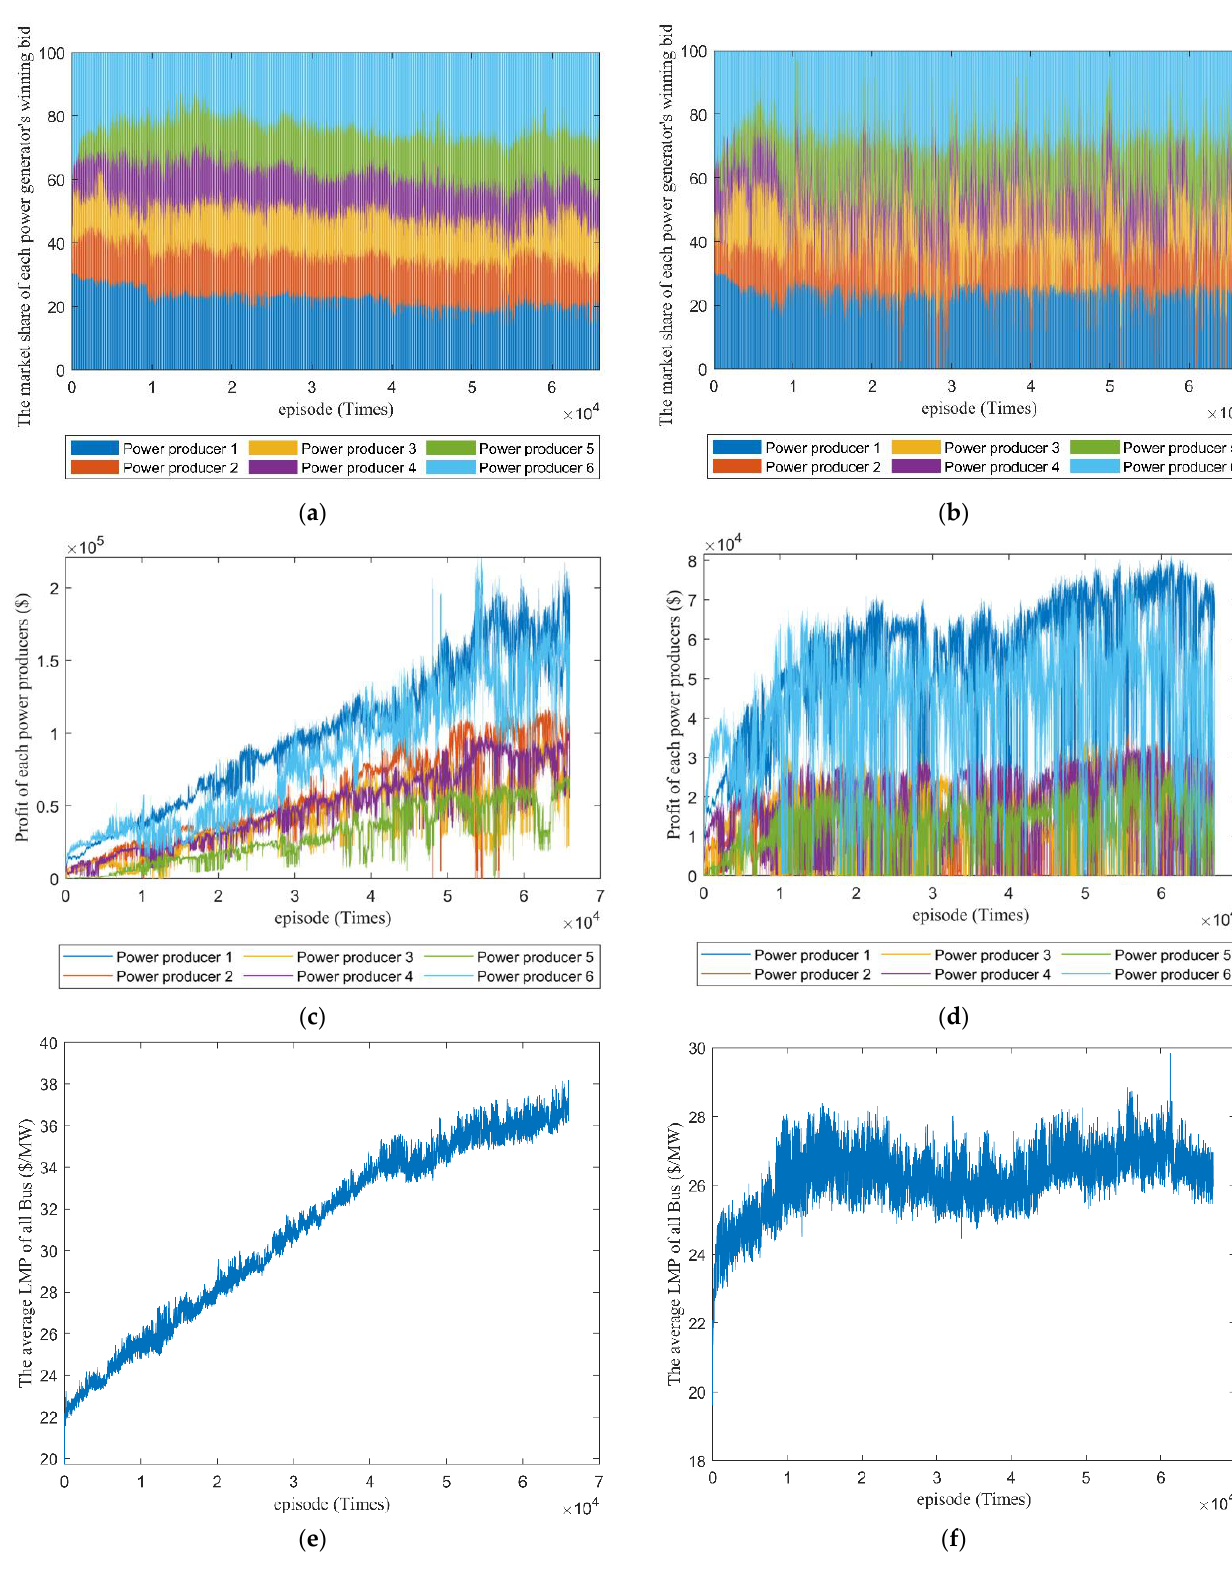
Figure 6. ( a ). The market share of all power producers in Scenario 1. ( b ). The market share of all power producers in Scenario 2. ( c ). The profits of all power producers in Scenario 1. ( d ). The profits of all power producers in Scenario 2. ( e ). The average LMP of all buses in Scenario 1. ( f ). The average LMP of all buses in Scenario